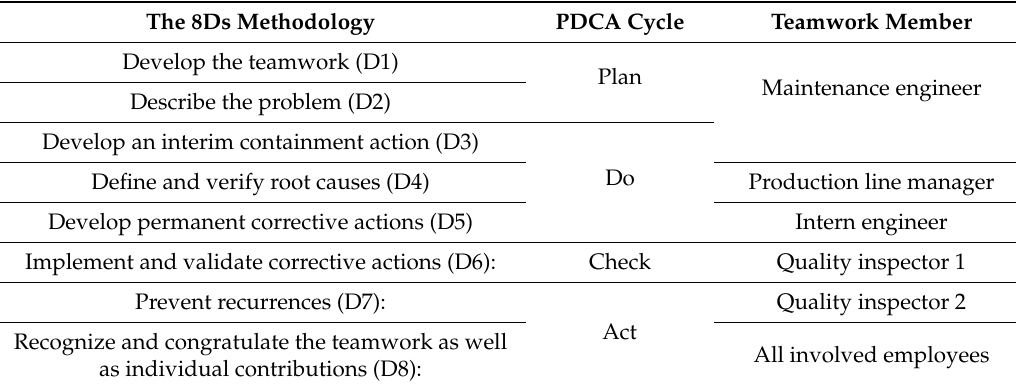
Table 3. Task assignment.